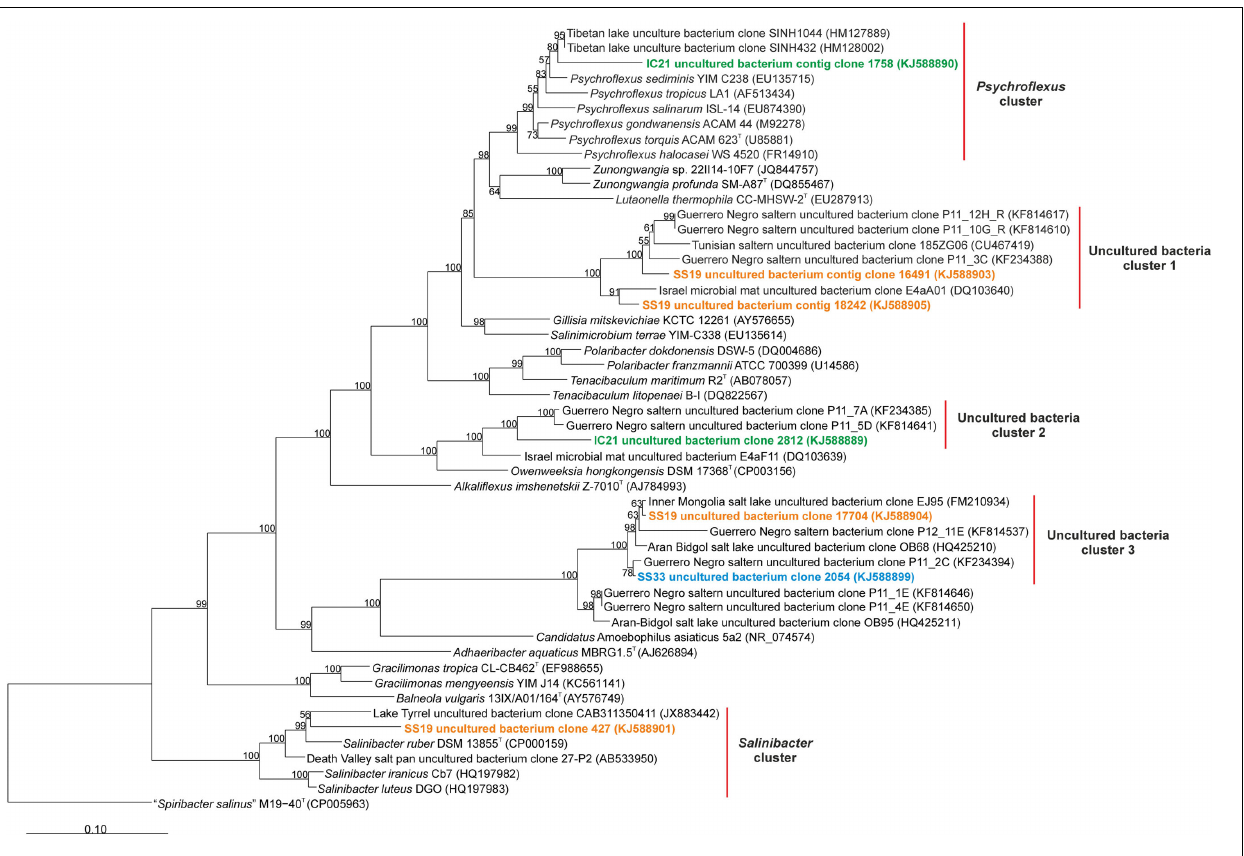
FIGURE 7 | Phylogenetic affiliation of the Bacteroidetes 16S rRNA reads of the datasets SS19, IC21 and SS33. Phylogenetic reconstruction was conducted by maximum likelihood (RAxML) with near full length (1300 nt) reference 16S rRNA gene sequences from a manually curated alignment and